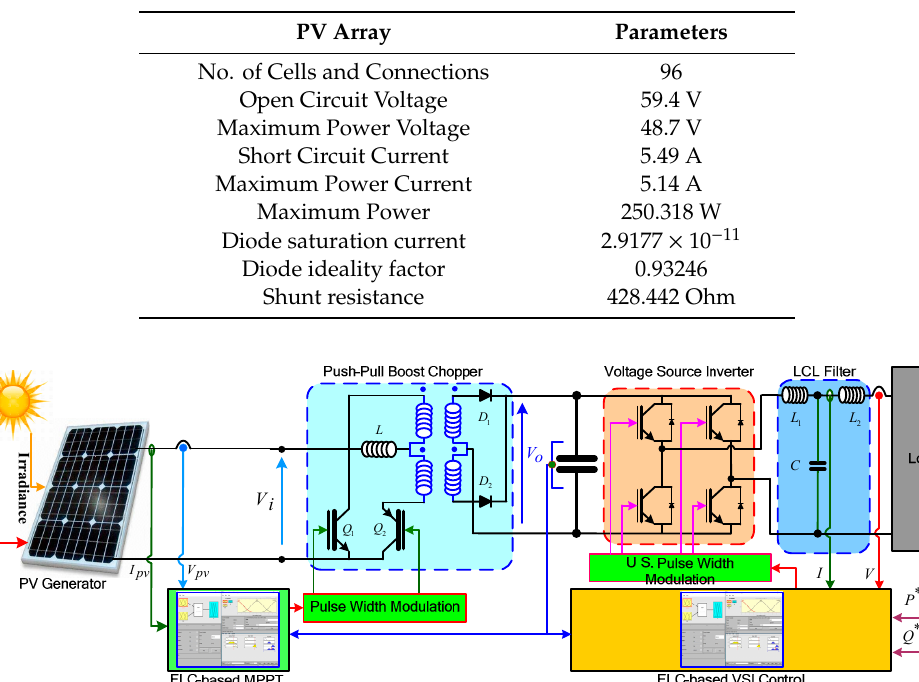
Table 4. Parameters of photovoltaic (PV) array.